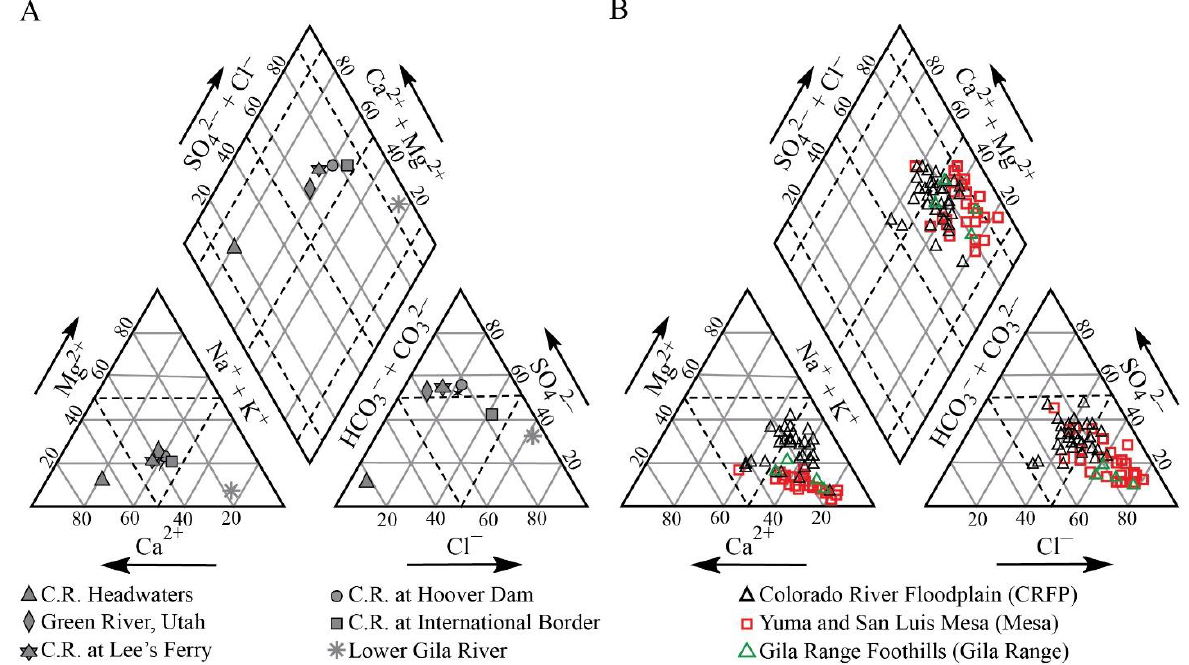
Figure 7. ( A ) Piper diagram showing data for surface waters in the Colorado River Basin including data for headwaters (USGS Station 09196500), Green River, Utah (USGS Station 09315000), Lee’s Ferry (USGS Station 09380000), Hoover Dam (USGS Station 09421500), US–Mexico border (USGS Station 09522000), and Gila River near Dome, Arizona (USGS Station 09520500). All USGS data are available online from [17]. ( B ) Piper diagram showing data for groundwaters in the study area, including Colorado River Floodplain, Yuma and San Luis Mesas, and Gila Range.